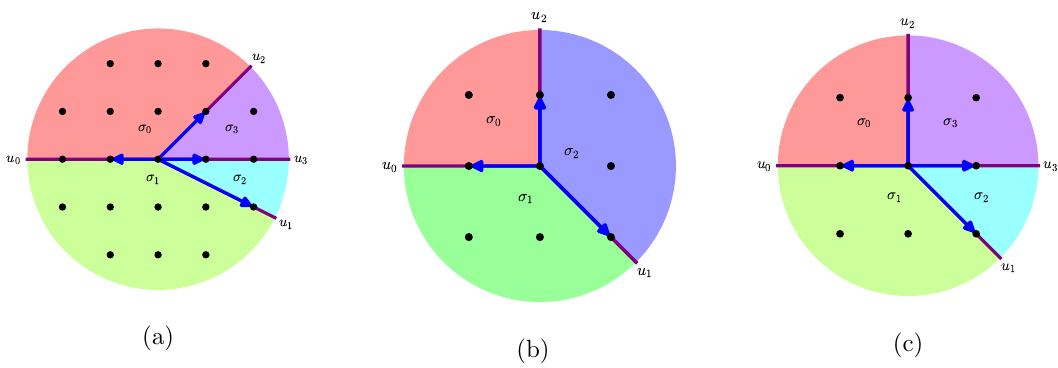
Figure 1. (a) The complete resolution f X 0 is constructed from the zeroth-grade point. The Euler number (cid:31) 0 is 4. (b) The toric variety X 1 is already smooth, viz, X 1 = f X 1 . The Euler number (cid:31) 1 is 3. (c) We make a further blow-up on X 1 by adding the ray u 3 = (1 ; 0). The new variety f X 0 Euler number (cid:31) 0 = 1